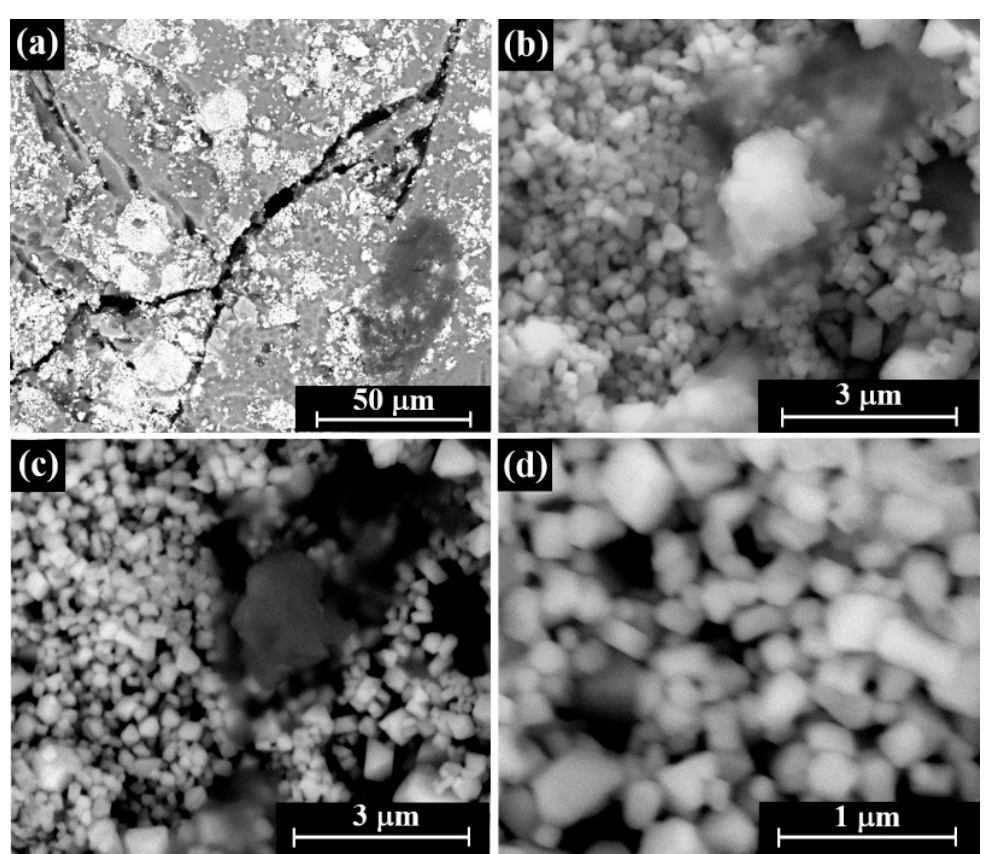
Figure 11. SEM images of yellow pigment (tile no. 340, Type A): ( a ) cracked white glaze matrix with yellow pigment particles (bright particles) and ( b – d ) higher magnification of yellow pigment particles.